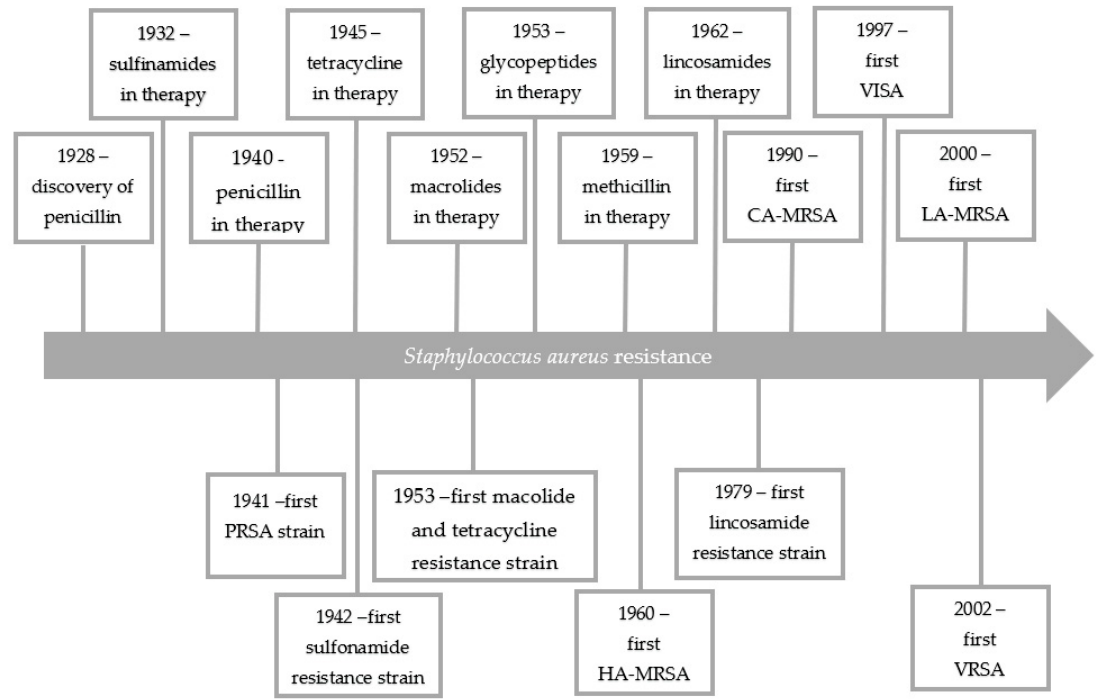
Figure 1. The development of resistance among S. aureus over the years [1,12]. PRSA—Penicillin Resistance S. aureus.